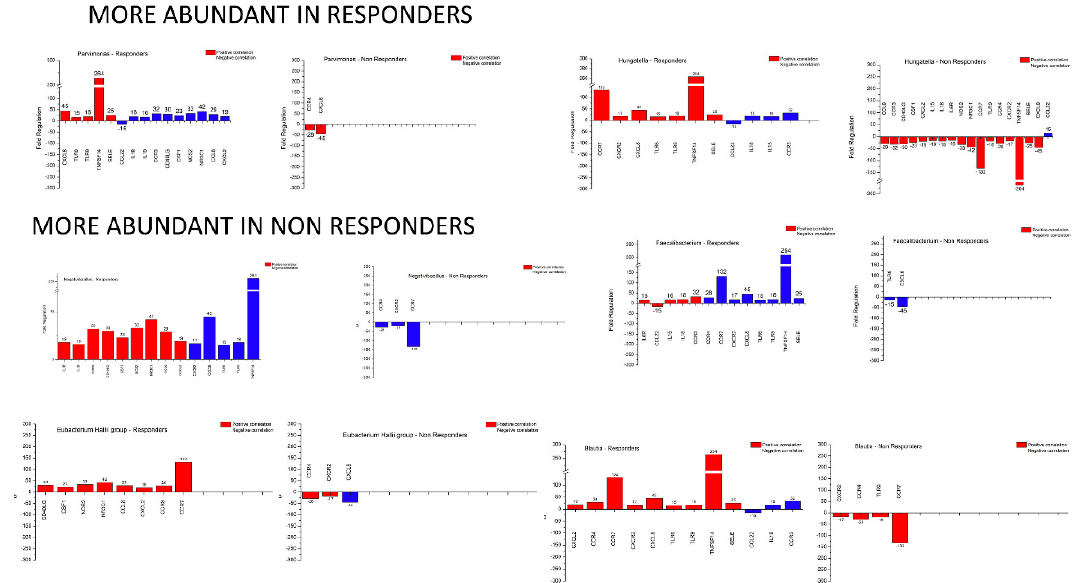
Figure 7. Overview of the genera with differential abundance between responders and non ‐ responders and how these correlate with specific differentially expressed genes. IL18, CCR3, CXCL8, TLR6, TLR9 and TNFSF14 are upregulated and CCR4 is downregulated in both groups (2/2 genera abundant in responders and 3/4 abundant in non ‐ responders) and appear to meet the criteria to be characterised as biomarkers for prediction of response to IFX therapy.